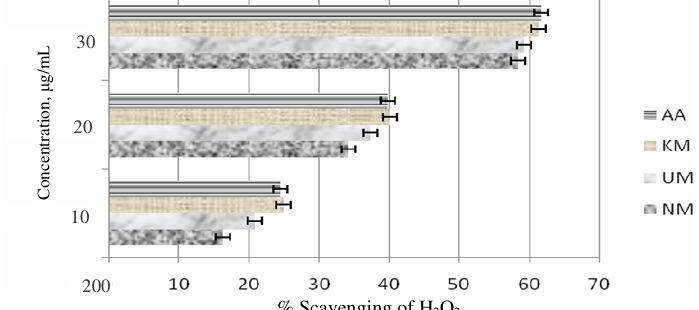
Figure 2. Hydrogen peroxide radical scavenging activity of NM, UM and KM (Values are mean ± SD of five